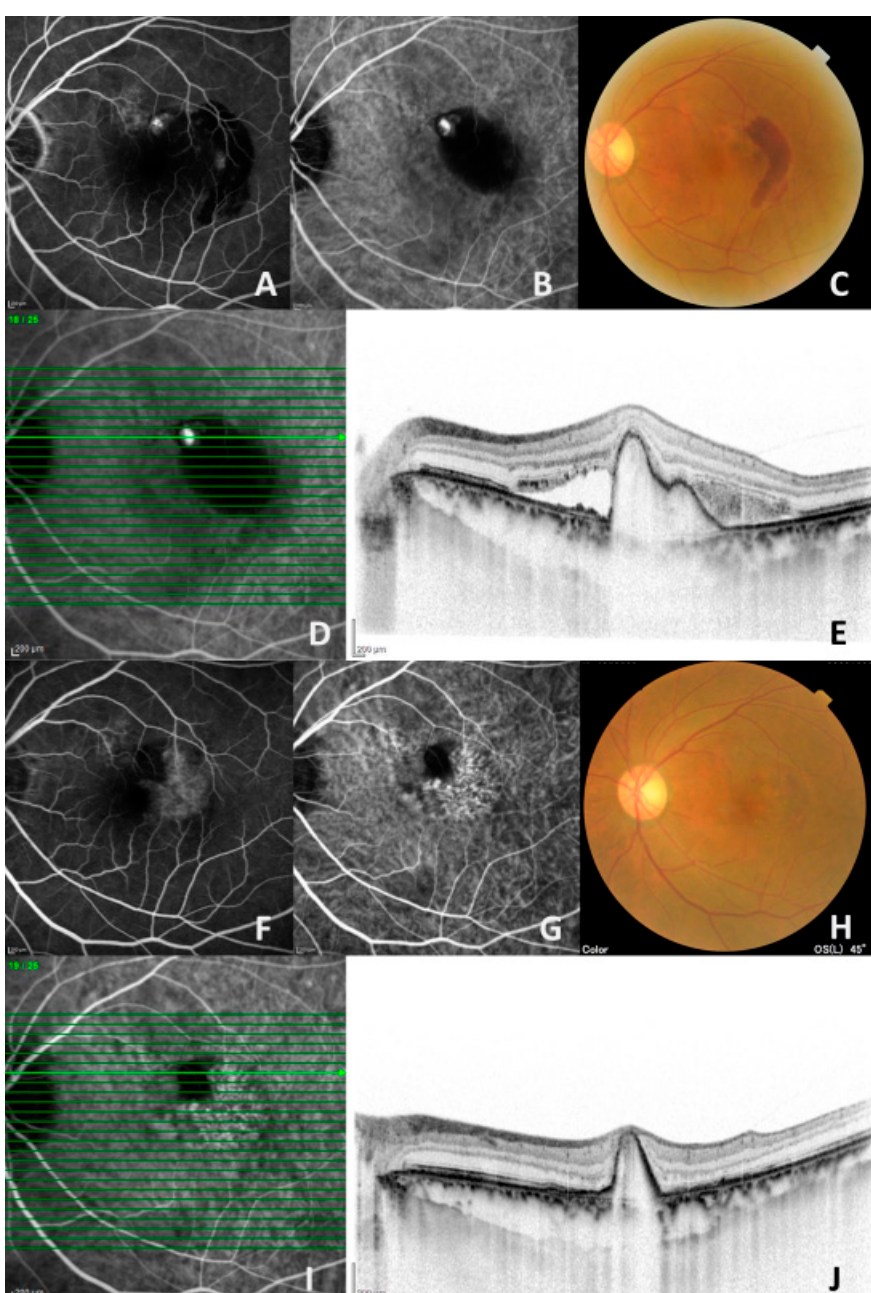
Figure 4. A representative case (76-year-old man) treated with a 3-monthly intravitreal injection of brolucizumab. ( A , B ) Fluorescein angiography (left) and indocyanine angiography (ICGA) (middle) demonstrated a hyperfluorescent spot corresponding to a polypoidal lesion at baseline. ( C ) Color fundus photography showed an orange-red lesion and subretinal hemorrhage before treatment. ( D , E ) Horizontal optical coherence tomography (OCT) demonstrated retinal pigment protrusion with subretinal fluid and hemorrhage corresponding to a polypoidal lesion on ICGA at baseline. ( F – H ) Fluorescein angiography (left) showed staining on the temporal side at the 3-month visit. The polypoidal lesion disappeared on ICGA at the 3-month visit (middle). Subretinal hemorrhage also disappeared on color fundus photography at the 3-month visit (left). ( I , J ) On a horizontal OCT scan corresponding to an original polypoidal lesion, retinal pigment epithelial protrusion remained without subretinal